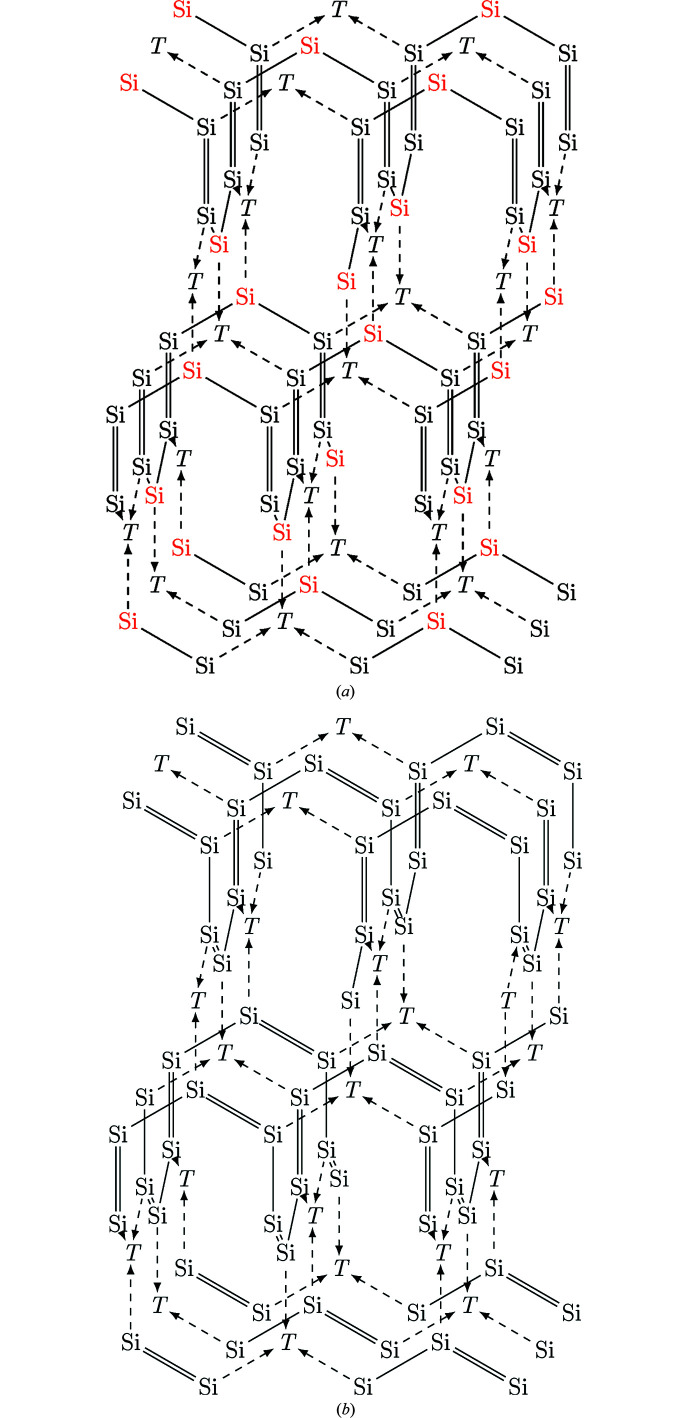
Distribution of single and double bonds in R
2
TSi3 compounds with the proposed tetragonal structure with Si/T ordering: (a) double bonds only in interchain direction and (b) double bonds in inter- and intrachain direction These figures only include the Si/T sublattice. Dashed arrows indicate the coordinative bonds between Si and T atoms. The Si highlighted in red are neutral, the black Si have a charge of −I.